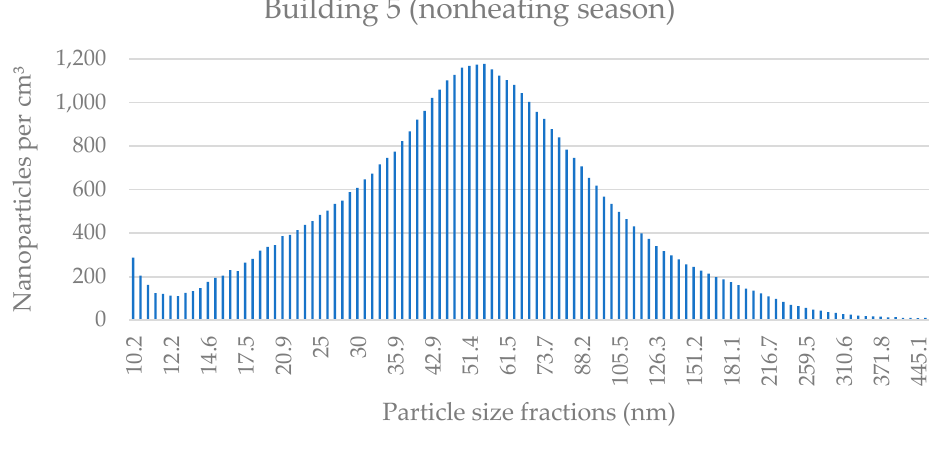
Figure A11. The average nanoparticle concentration in each size fraction in Building 6 during a one- week measurement period during the heating season. Figure A12. The average nanoparticle concentration in each size fraction in Building 6 during a one- week measurement period during the nonheating season.